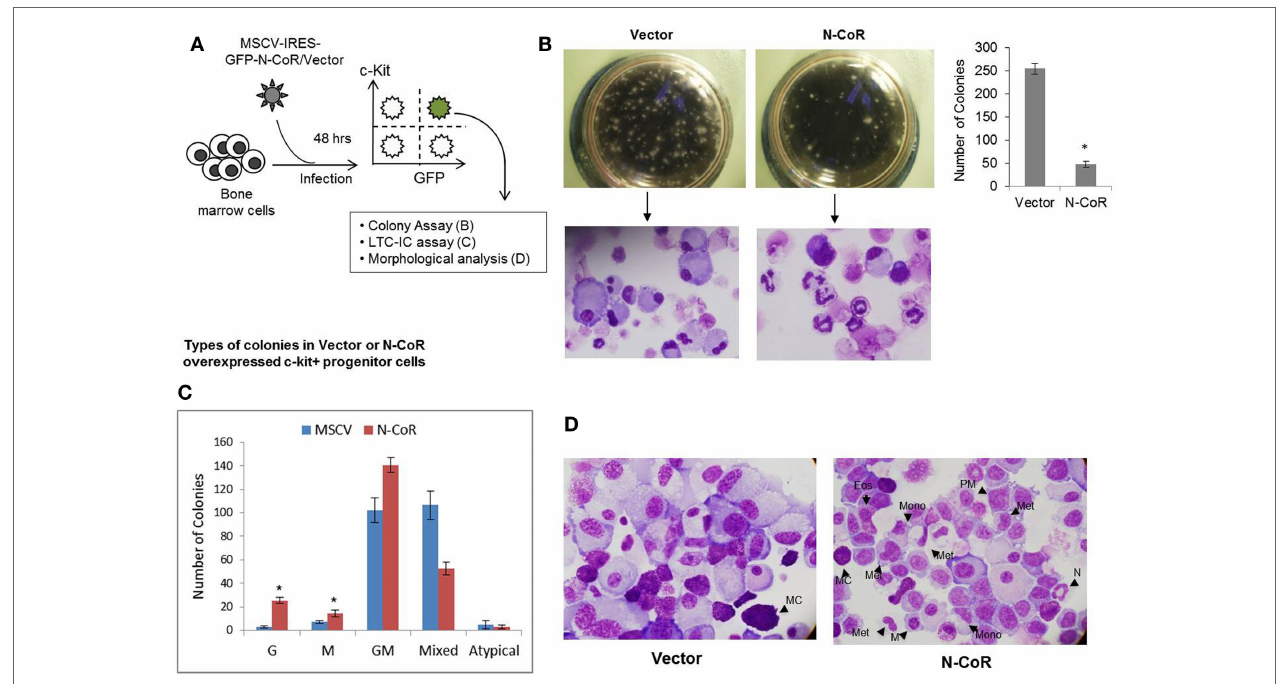
FigUre 2 | enforced n-cor expression in c-Kit + stem cell/progenitor cells inhibits their growth and promotes commitment toward myeloid lineage . (a) Schematic representation of the experiments performed with mouse bone marrow cells transduced with N-CoR or control vector. (B) Enforced N-CoR expression in c-Kit + stem cell/progenitor cells inhibits their self-renewal potential. The growth and commitment of mouse primitive hematopoietic cells transduced with MSCV-IRES-GFP-N-CoR or empty vector were determined in colony formation assay and Wright–Giemsa staining. The number of colonies derived from vector or N-CoR-infected cells (left panel) was counted and data were plotted as bar graph (right panel). Asterisk represents statistical significance in Student’s t -test, p < 0.01. Error bars indicate mean ± SD. (c) Colony-forming unit (CFU)-culture assay: the number of granulocyte (G), macrophage (M), granulocyte–macrophage (GM), and mixed colonies (granulocyte, erythroid, monocyte, and megakaryocyte) formed by GFP- and c-Kit-positive cells treated with G-CSF in methylcellulose medium for 10 days was scored and plotted as bar graph. Asterisks represent statistical significance in Student’s t -test, p < 0.01. Error bars indicate mean ± SD. (D) Morphology of purified mouse bone marrow cells transduced with MSCV-IRES-GFP-N-CoR or control vector was determined with Wright–Geimsa staining where eosinophils (Eos), mast cells (MC), meta-myelocytes (Met), monocytes (Mono), myelocytes (M), neutrophils (N), and promyelocytes (PM) are labeled (right